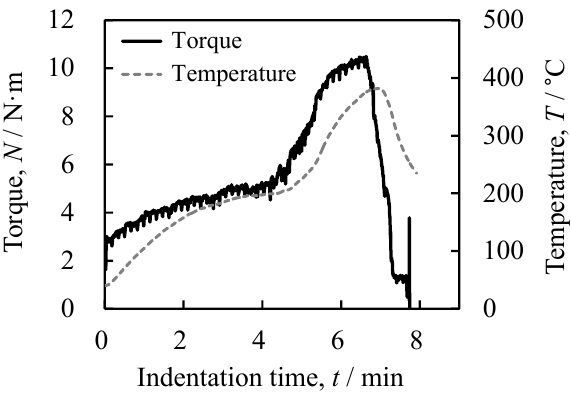
Figure 3. Torque N – indentation time t and temperature T – t relationships during FSBE.